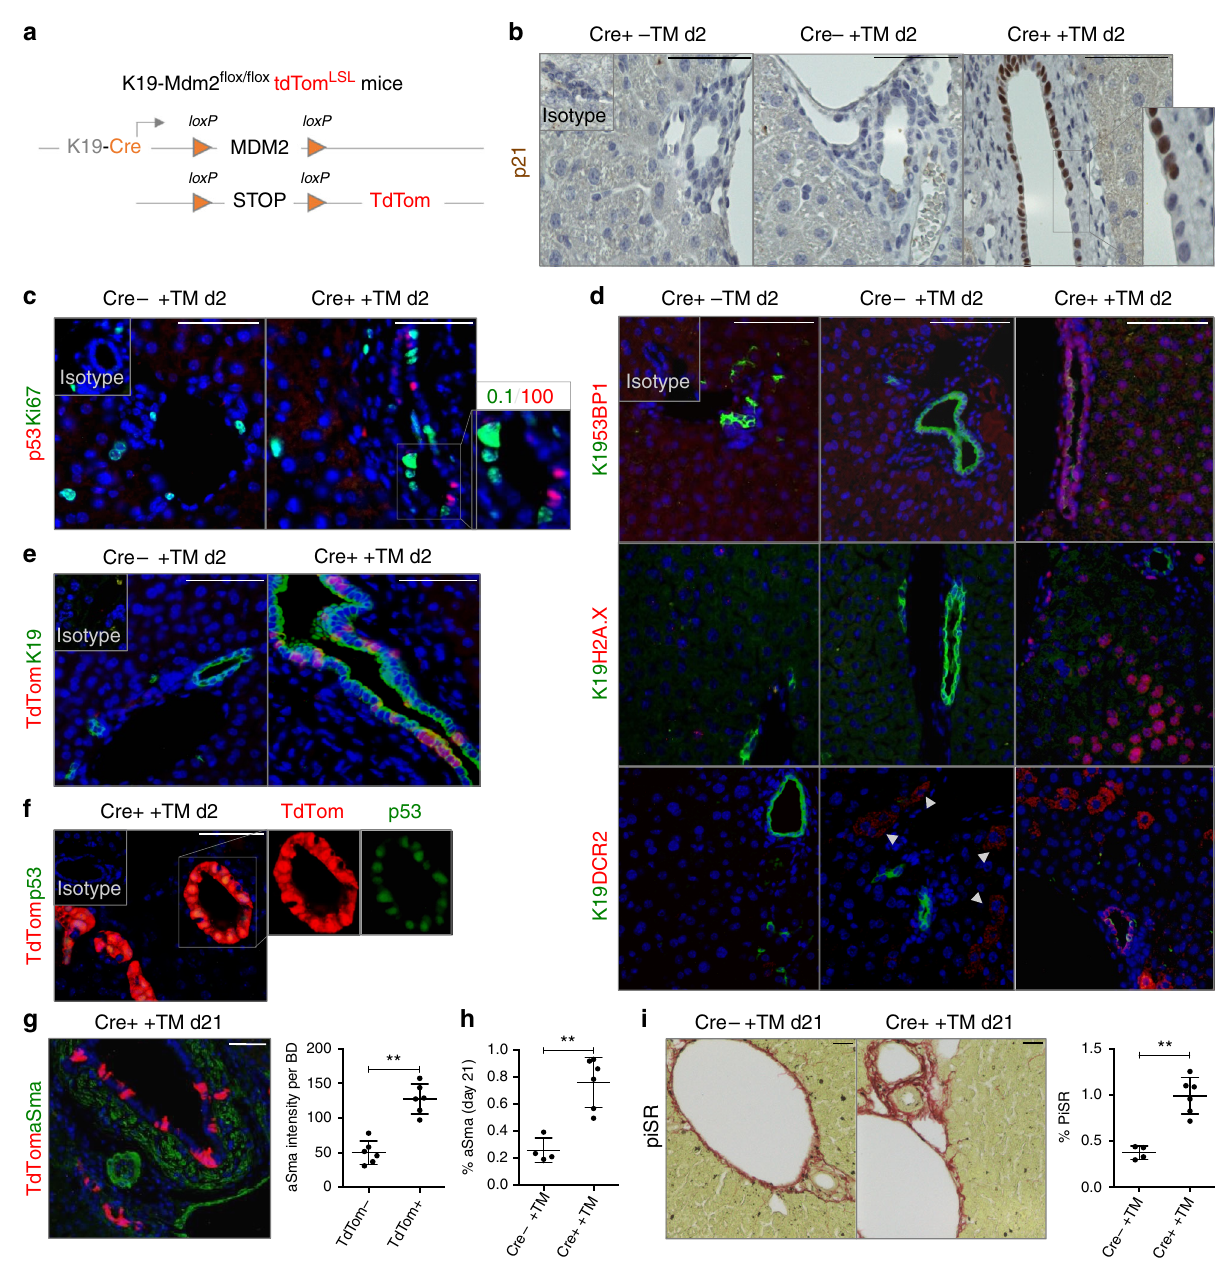
Fig. 2 Cholangiocyte-speci fi c deletion of Mdm2 results in p21-driven cellular senescence. a Schematic explanation of the model: K19CreER T promoter is used to fl ox out Mdm2 in cholangiocytes. Upon tamoxifen administration, Cre recombinase is activated and Mdm2 is cleaved. The STOP sequence upstream tdTom reporter sequence is also fl oxed out making the identi fi cation of primary senescent events traceable through tdTom expression. b Increased levels of p21 in bile ducts 2 days after tamoxifen administration. Mouse data is presented at day 2 after fi nal tamoxifen administration ( N = 6 per group). (Left) K19Cre-positive mice without tamoxifen injection. (Center) K19Cre-negative mice after tamoxifen injection. (Right) K19Cre-positive mice after tamoxifen injection. c Cell-cycle-arrested cells do not proliferate. 0.1% (Mean ± SEM) of cholangiocytes co-express p53 (red) and Ki67 (green) 2 days after tamoxifen administration. d From top to bottom: 53BP1, γ H2A.X and DCR2 (red) in K19-positive cholangiocytes (green). Notice the presence of 53BP1-positive, γ H2A.X-positive and DCR2-positive hepatocytes in Cre + + TM group. Bottom panel: Cre − + TM shows some DCR-positive hepatocytes (white arrowheads). e Recombined K19-positive cholangiocytes (green) can be traced by means of tdTom expression (red). f tdTom (red) co-localizes with p53 (green) in bile ducts. g Increased intensity of α SMA-positive cells (green) contiguous to tdTom-positive senescent-cholangiocytes (red) compared with tdTom-negative bile ducts at day 21 after induction N = 6. For an explanation about how this result was acquired, refer to Supplementary Fig. 5. h Increased total percentage of α SMA-positive cells in the Cre + + TM group at day 21. i Increased deposition of collagen measured by PicroSirius Red (PiSR) at 21 days after tamoxifen induction. Right, quanti fi cation. ** denotes p < 0.01 (Mean ± SEM), Student ’ s t test. Scale bars = 50 µ